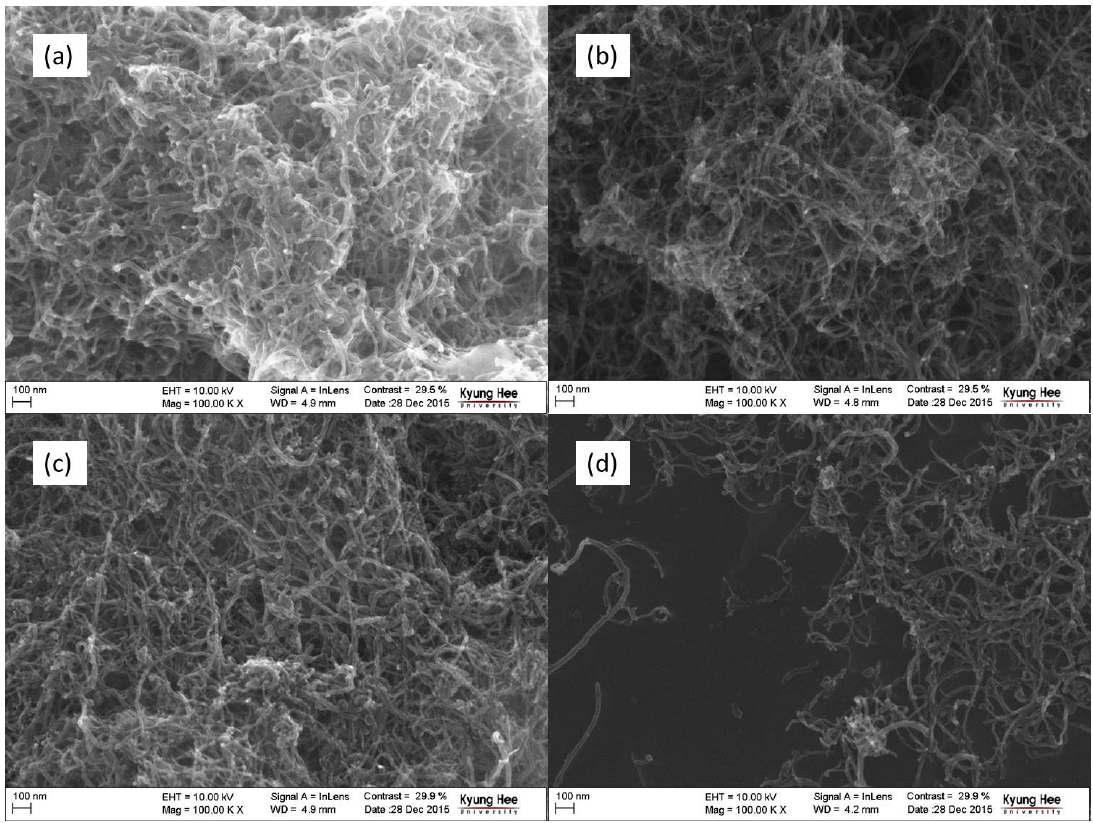
Figure 1. Field electron scanning electron microscope (FE-SEM) images of carbon nanotubes (CNTs): ( a ) raw CNT (RCNT); ( b ) Cr-10-10; ( c ) Cr-20-10; and ( d ) Cr-25-10. The sample Cr-25-10 shows less